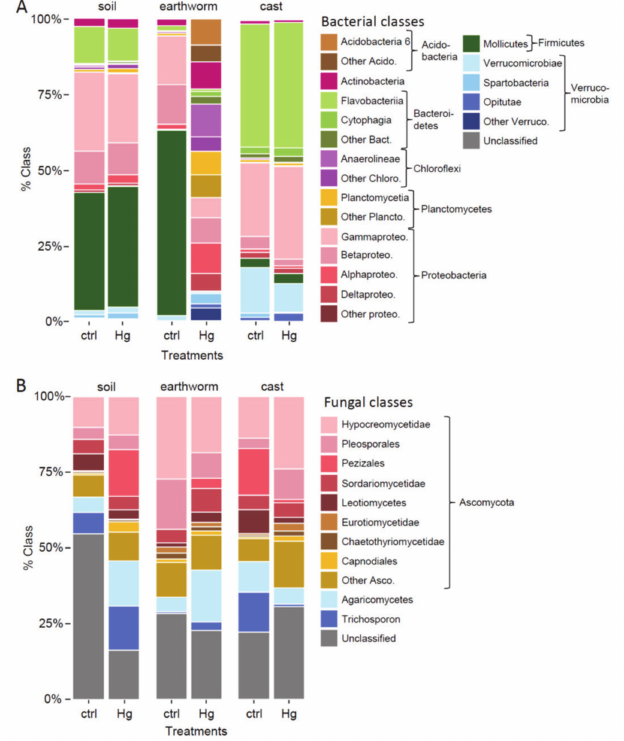
Figure 4. Relative abundance of bacterial ( A ) and fungal ( B ) phyla and classes across the treatments (Hg = Hg-contaminated, ctrl = uncontaminated control) and the sample types (soil, earthworm and cast) in experiment